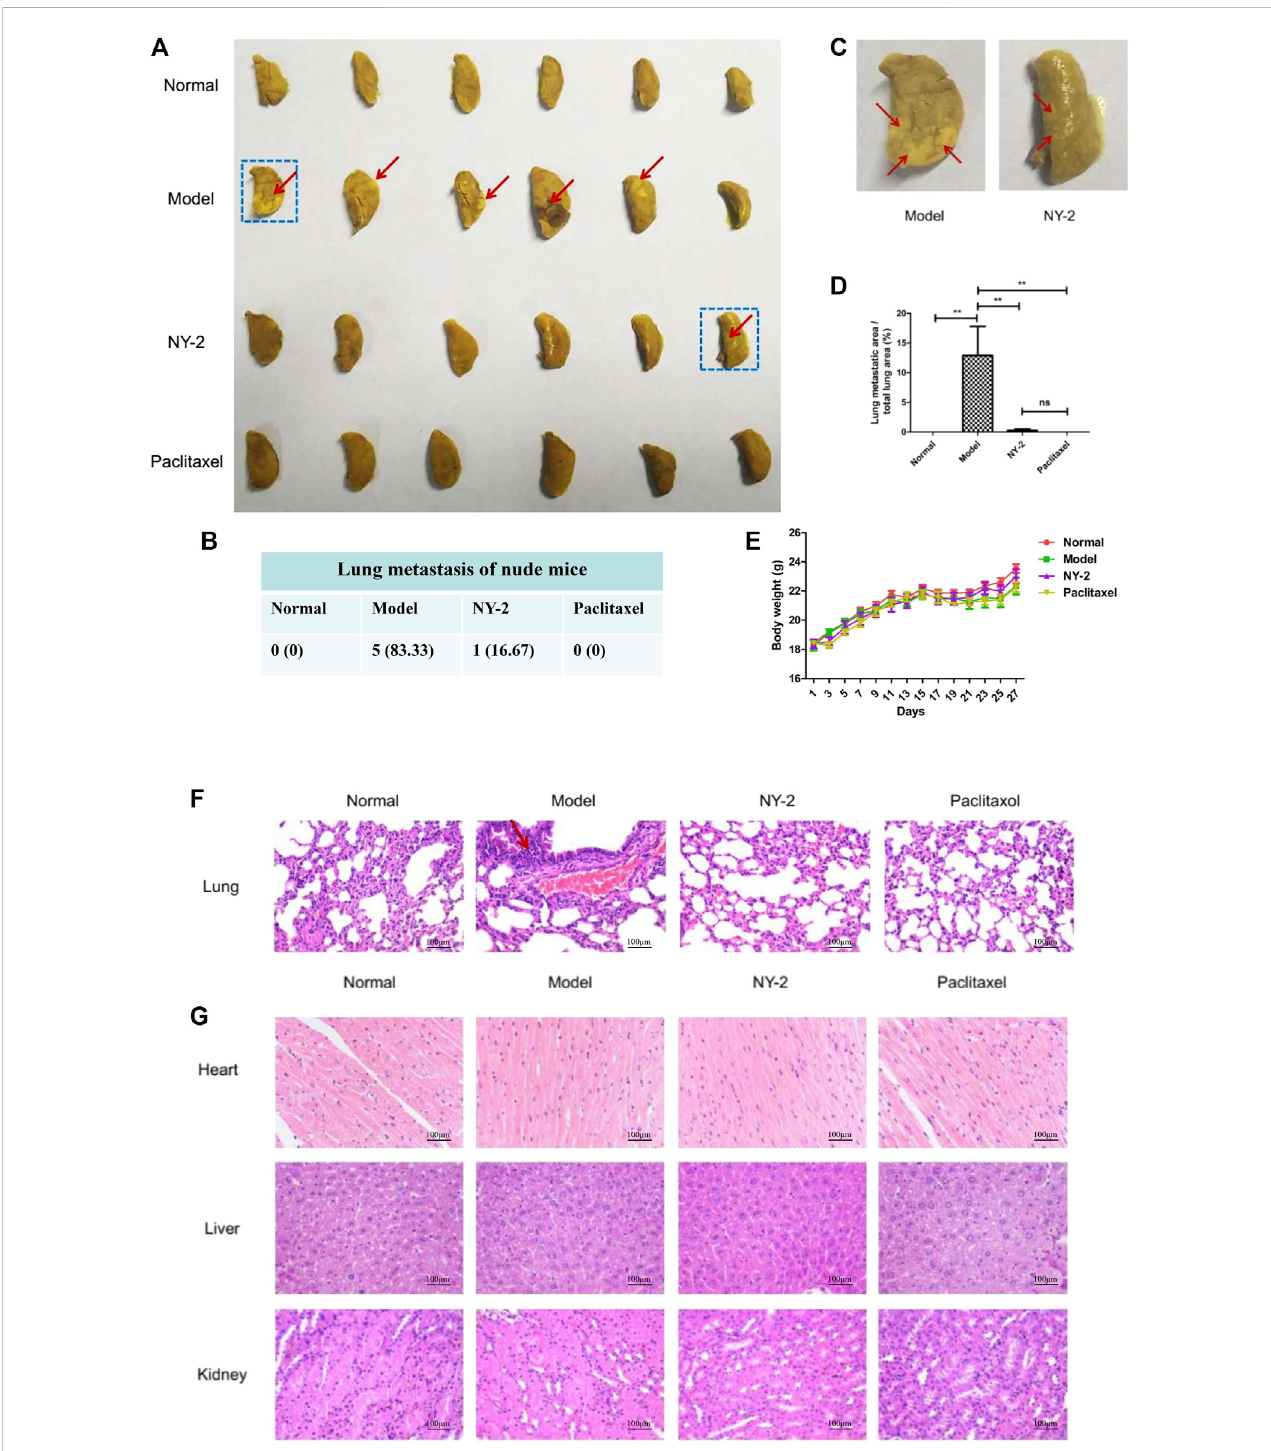
FIGURE 6 InvivoactivityofNY-2againstNSCLC.TheleftlungsofnudemicefromeachgroupafterstainingwithBouin ’ ssolution (A) .Lungmetastasesinnudemice fromeachgroup (B) .EnlargedleftlungmarkedwithblueboxfromFigure (A)(C) .Percentageofthemetastatictumorarearelativetothetotallungareaofnude miceineachgroup (D) .EffectofNY-2onbodyweightoftumor-bearingnudemice (E) .H&Estainingoflungtissuesections (F) .H&Estainingofheart,liver,and kidney tissue sections (G) . * p < .05, ** p < .01, *** p < .001 ( n = 6, mean ±